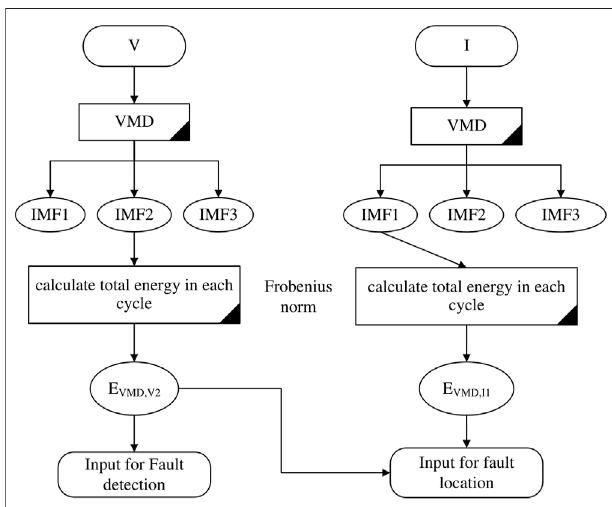
FIGURE 4 | VMD-based feature extraction procedure.